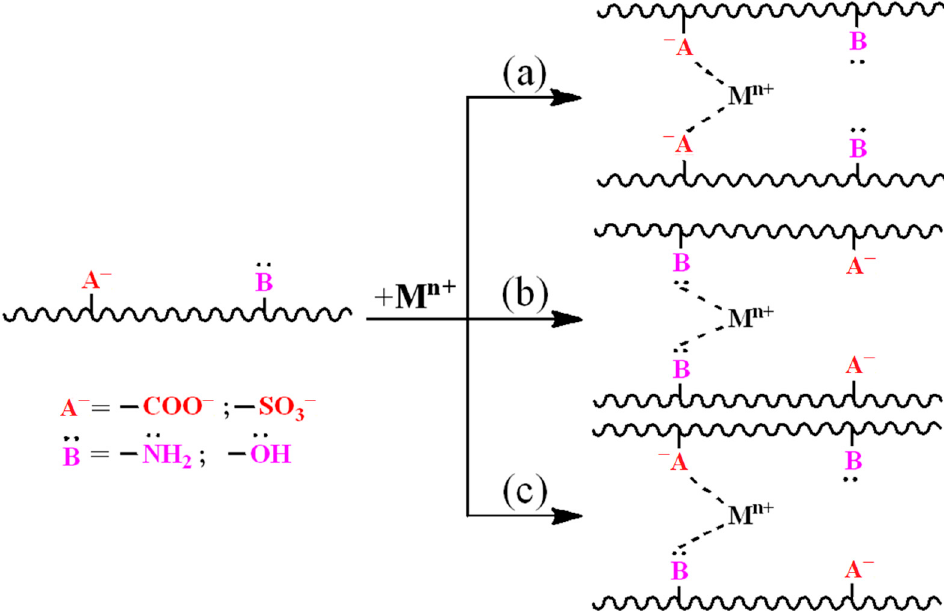
Scheme 1. Representation of the possible mechanisms of adsorption of heavy metal ions onto the surface of oxidized wool fibers: ( a ) ionic interactions; ( b ) coordinative (donor–acceptor) interactions, and ( c ) mixed ionic/coordinating interactions.